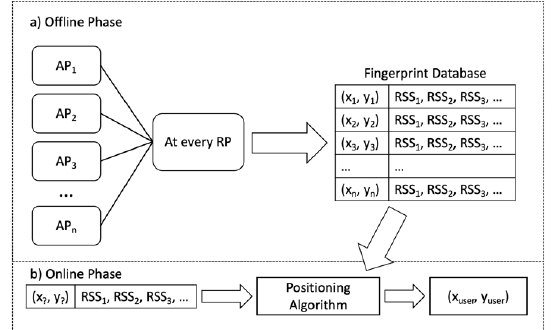
Figure 4: The process of installation and implementation of the Fingerprinting